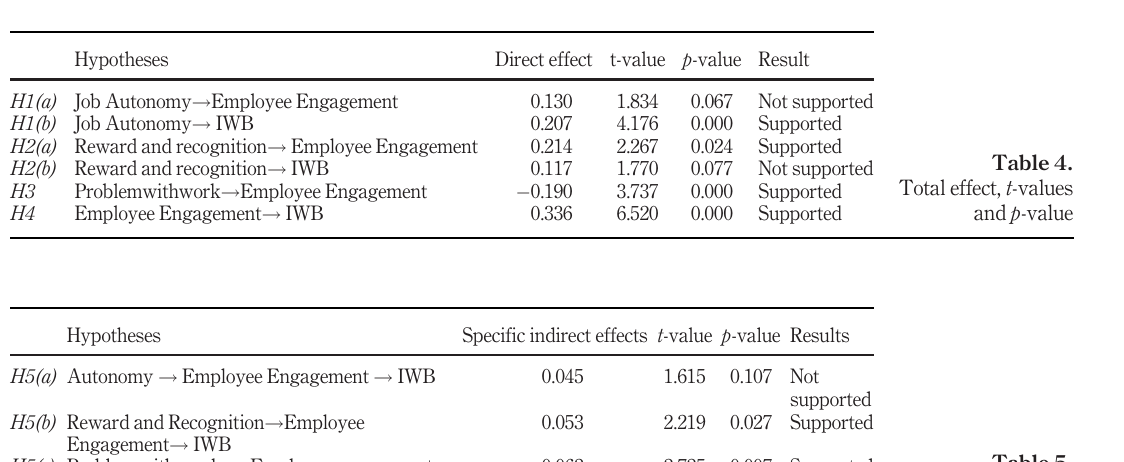
Table 5. Mediation